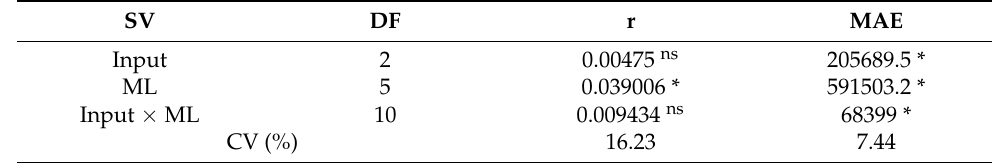
Table 3. Summary of analysis of variance for Pearson correlation coefficients (r) and mean absolute error (MAE) by different inputs and Machine Learning (ML) models tested.